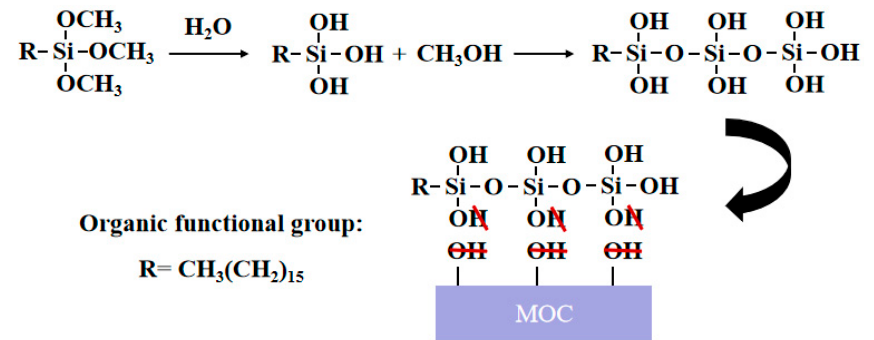
Figure 6. Setting time and fluidity of compound material–magnesium oxychloride cement composite ternary system.